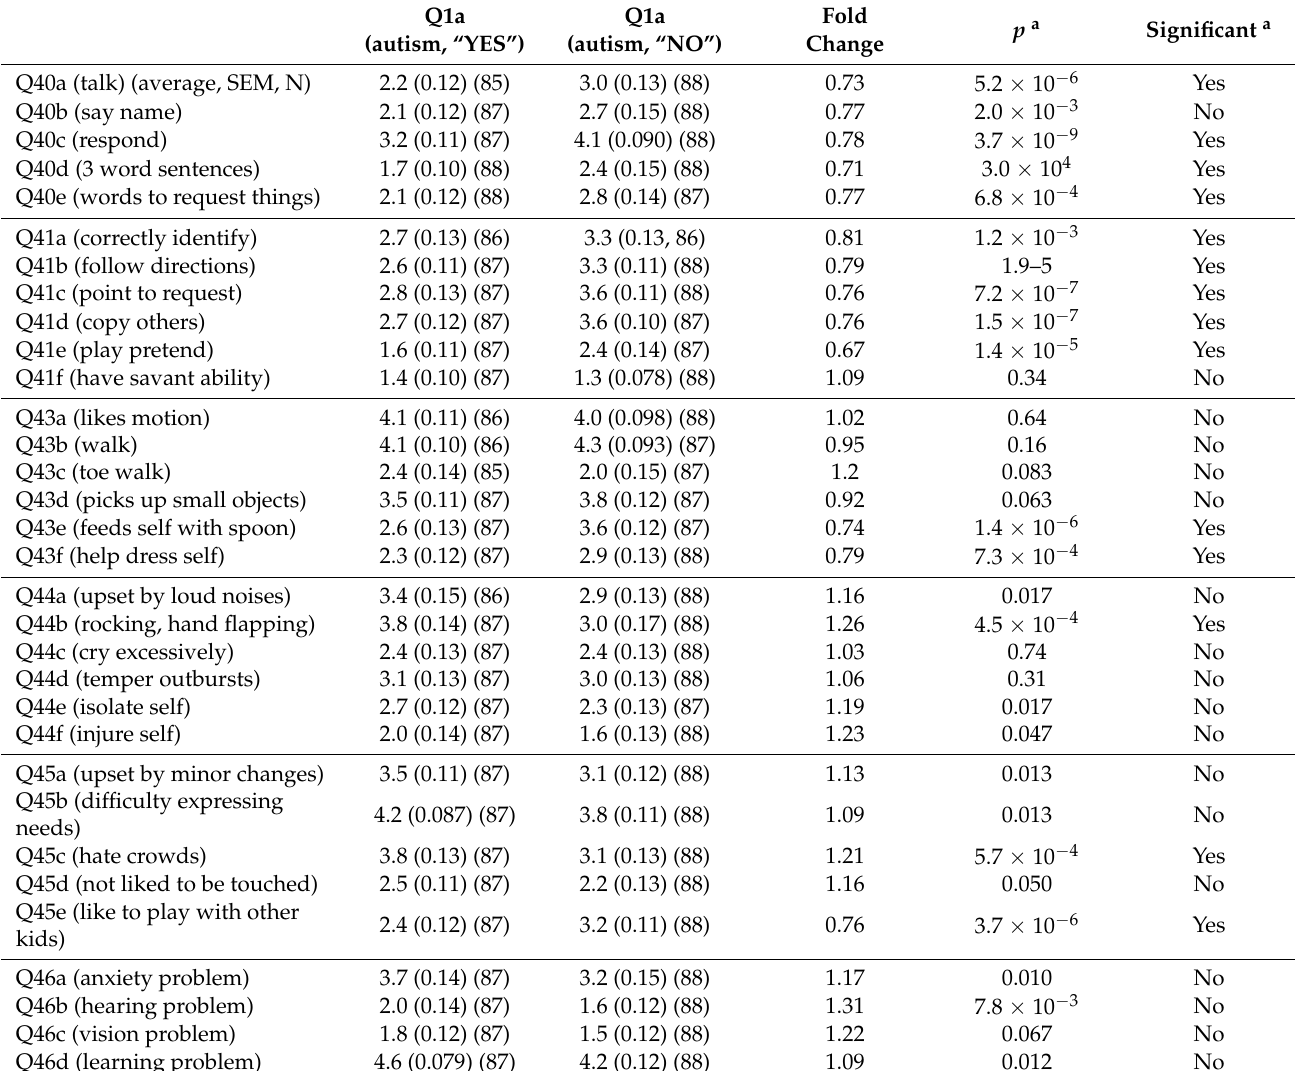
Table 4. Analysis of caregiver-reported autism and autism